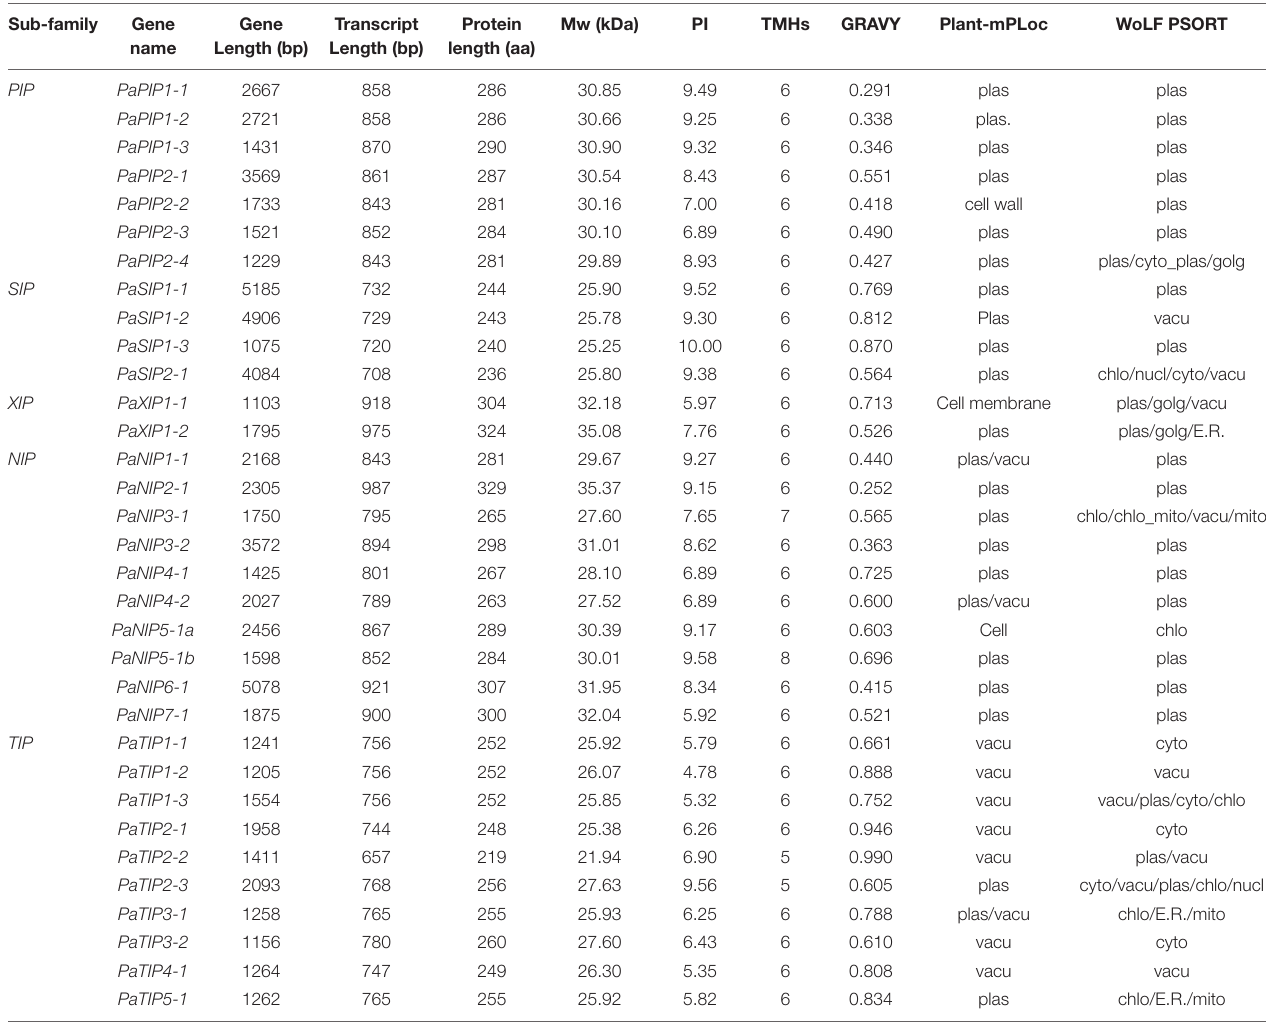
TABLE 1 | The PaAQP gene family identified in P. armeniaca.